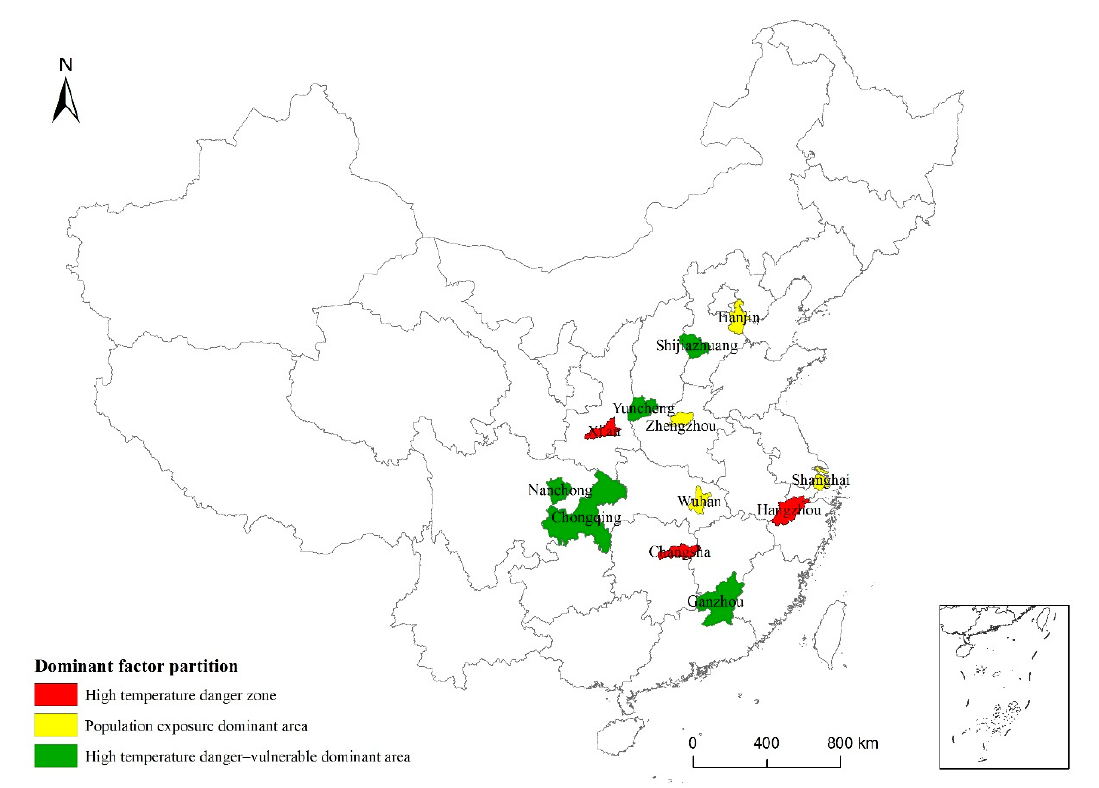
Figure 8. High-temperature risk dominant factor partition for 31 typical cities in China.